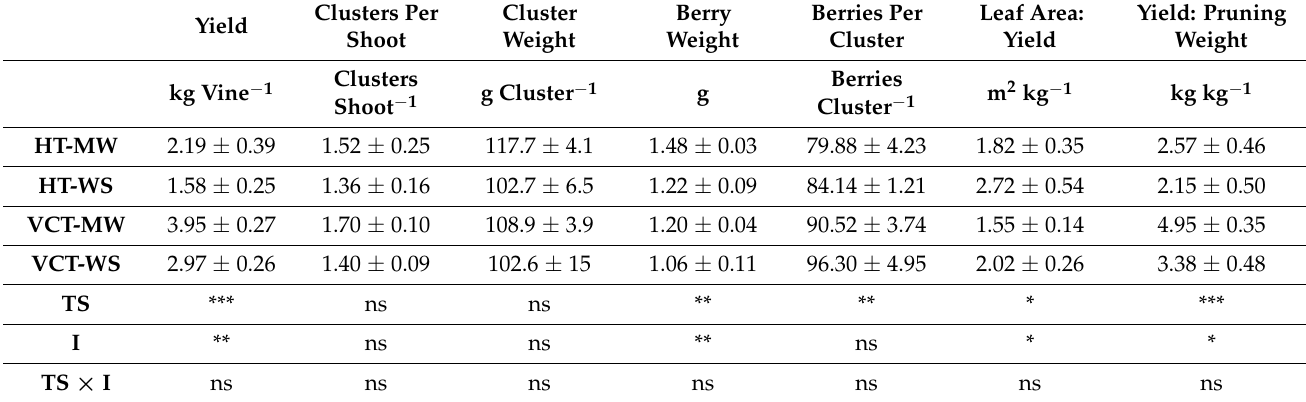
Table 4. Yield and yield components of the different